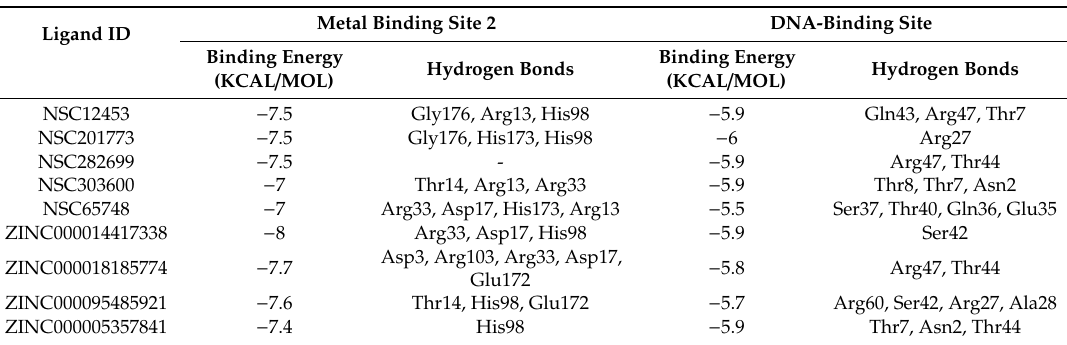
Table 8. Binding energies and hydrogen bond interactions of selected lead compounds and the five potent inhibitors screened against metal binding site 2 and the DNA–binding site respectively. A hydrogen bond interaction was generated with LigPlot +